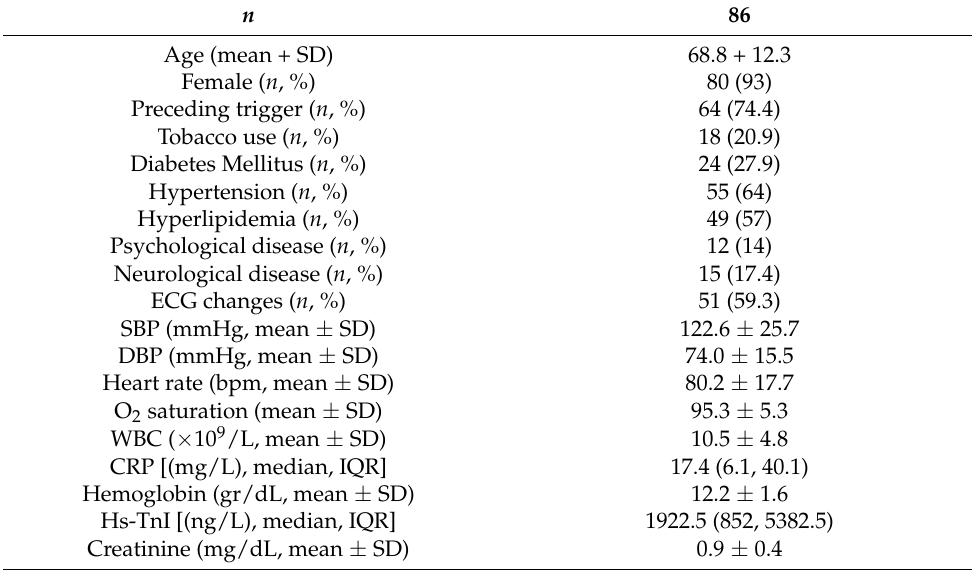
Table 1. Baseline clinical characteristics and laboratory data of the study